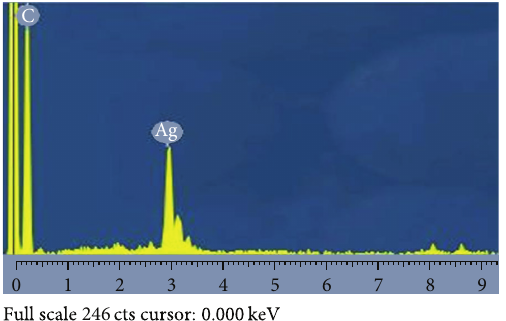
Figure 6: Energy-dispersive X-ray spectral analysis of polystyrene/ Ag